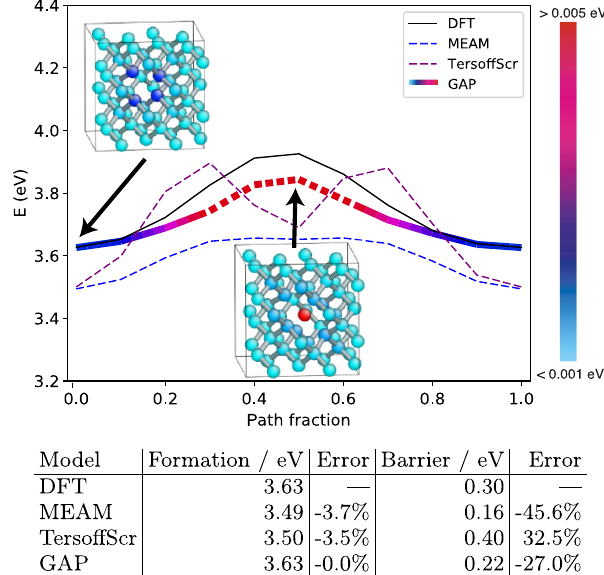
FIG. 25. Comparison of the DFT, GAP, MEAM, and TersoffScr models for the migration of a vacancy. Lines show NEB minimum energy pathways for a 63-atom cell, with the thick GAP line and inset images colored by the predicted error, becoming dashed where the maximum error exceeds 0 . 005 eV = Å, showing that the model is more confident at the minima than the saddle.